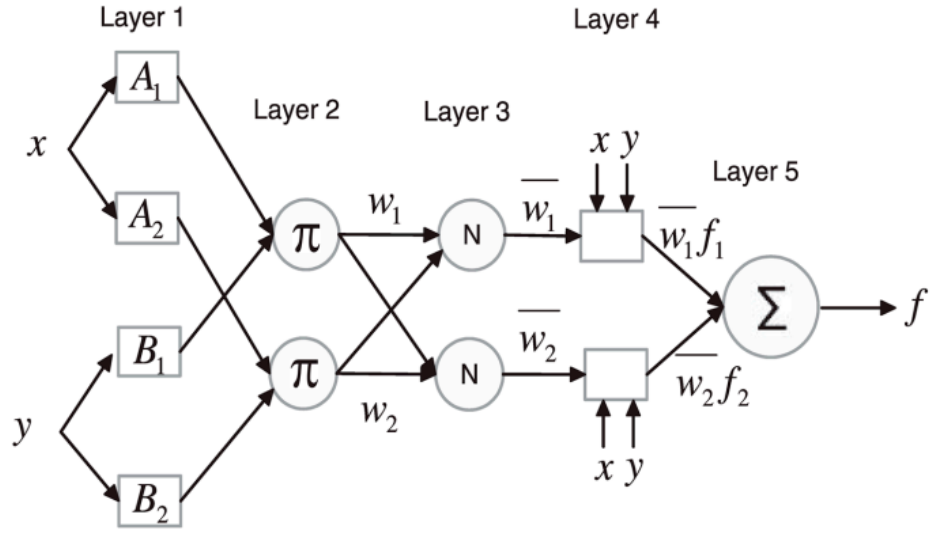
Figure 1. Structure of Adaptive Neuro Fuzzy Inference System.